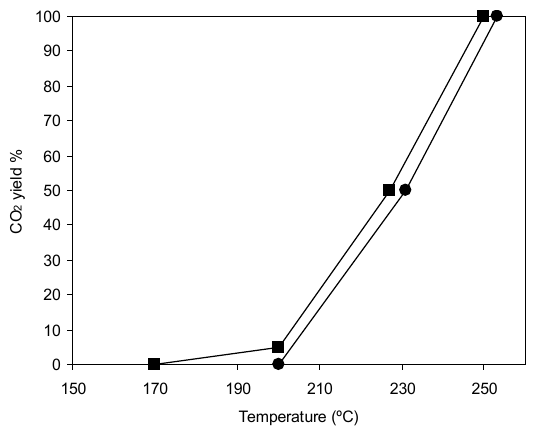
Figure 5: Naphthalene combustion vs. temperature for: RhCoCli-Mor and RhCoCli. Reaction conditions: catalyst 0.100 g, total